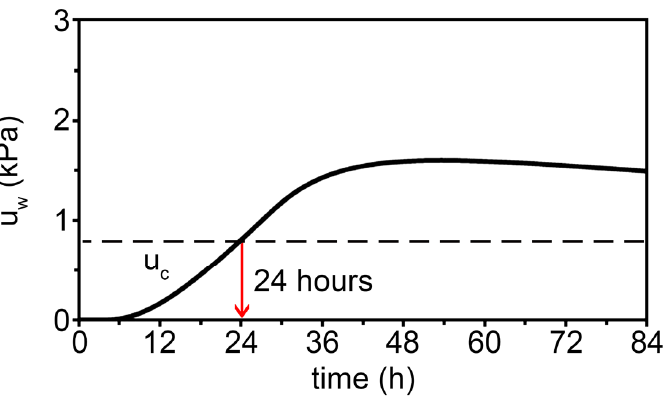
Figure 18. Evolution of the change in pore water pressure, w u , with time due to the rainfall of 5 October 2005, with indication of the critical threshold, c u , at the depth of 1.40 m.